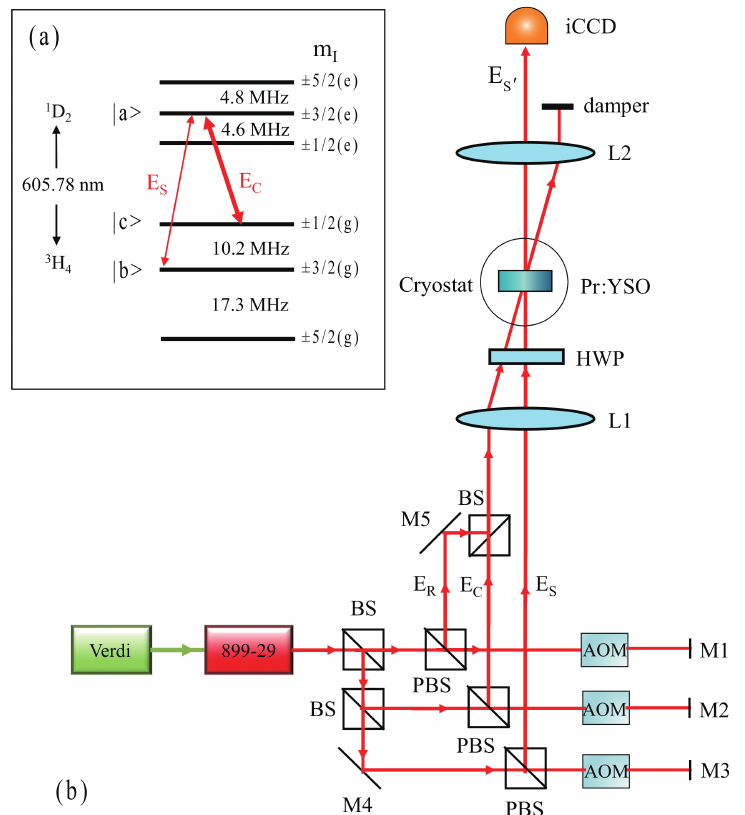
Figure 1. ( a ) Schematic diagram of the hyperfine multiplets of the transition 3 H 4 ↔ 1 D 2 of Pr 3 + ions on site 1 in YSO crystals, in which | a (cid:105) , | b (cid:105) and | c (cid:105) are three hyperfine energy levels to form the Λ -type energy level configuration for EIT-related experiments. ( b ) Schematic diagram of the experimental setup for EIT-related experiments in Pr:YSO crystals. BS: beam spliter, PBS: polarization beamsplitter, AOM: acousto-optic modulator, M1, M2, M3, M4 and M5: plane mirrors, L1: lens with a focal length f 1 = 30 cm, L2: lens with a focal length f 2 to image the output signal pulses onto the intensified charge-coupled device (iCCD). HWP: half-wave plate. The AOMs work in the double-pass configuration to eliminate the movement of the light spots, and the frequency tuning range is 110 ± 25 MHz. The HWP was used to change the polarization state of the three light